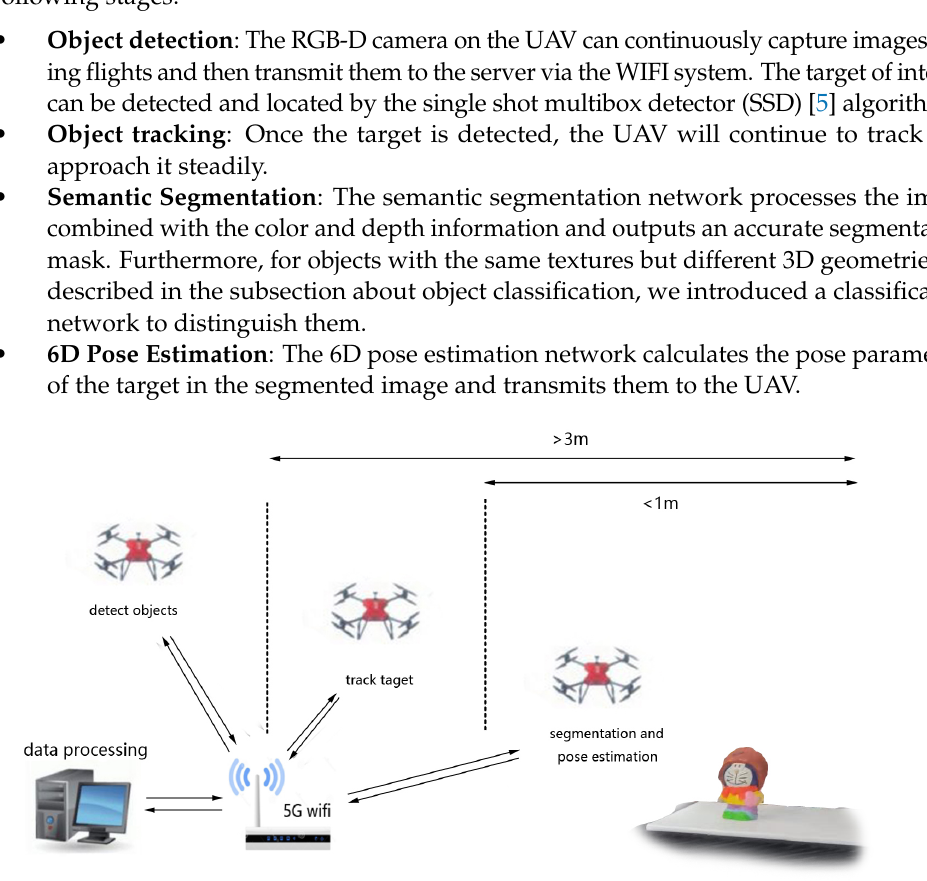
Figure 1. The hardware setup and workflow of the proposed vision system. (1) UAV: the UAV obtains pictures through the RGB-D camera, then transmits the data to the server via a WIFI system. (2) Server: the images are processed to detect, segment, classify the target of interest, and estimate its pose parameters. (3) Workflow: object detection: detect the target of interest in flight, the distance from the target is usually greater than 3 m; object tracking: approach and track the target, the distance to the target ranges from 1 to 3 m; semantic segmentation: segment the target pixels from the background and classify the target; 6D pose estimation: estimate the 6D pose parameters pixel-by-pixel in the target region. For segmentation and pose estimation, the distance is usually less than 1 m. The details of the above are described in Section 3. The main contributions of this study are as